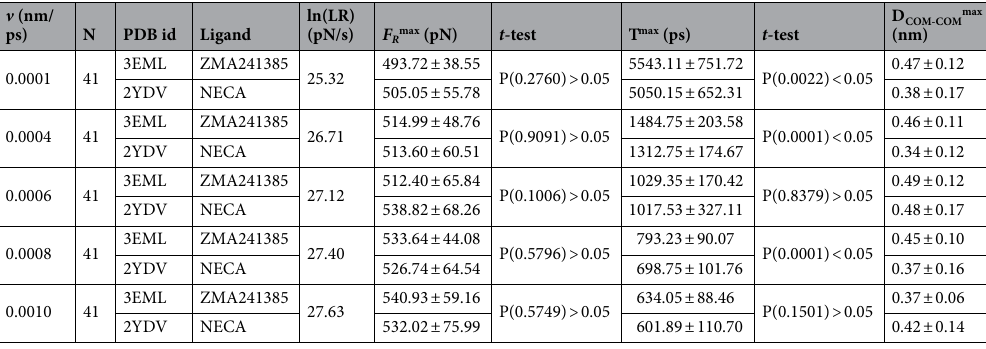
Table 1. Loading rate (LR), average maximum unbinding force ( F R max ), average maximum time (T max ) and average maximum distance (D COM-COMmax ) where COM of ligand was pulled from the COM of protein residues within 5 Å of ligand at each of the pulling velocities ( v ) from the SMD simulations of ZMA241385 and NECA ligand-receptor complexes. The LR are reported as their natural logarithms. The LRs at different v were calculated by multiplying the spring force constant ( k ), 600 kJ/mol/nm 2 , and the velocities ( v ), 0.0001 nm/ps, 0.0004 nm/ps, 0.0006 nm/ps, 0.0008 nm/ps and, 0.0010 nm/ps. The average of maximum unbinding forces ( F R max ) and the corresponding average maximum times (T max ) were estimated from the maximum forces and corresponding maximum times at individual replica simulations out of 41 replicas. Similarly average maximum distances (D COM-COM max ) between the COM of the ligand heavy-atoms and the COM of the binding pocket residues corresponds to maximum times at which the maximum forces were recorded for each replica of the system. Results from unpaired t -test for the ligand-pair at a given v for both the F R max and T max at a confidence interval of 95% and the number of replicas (N) are listed.